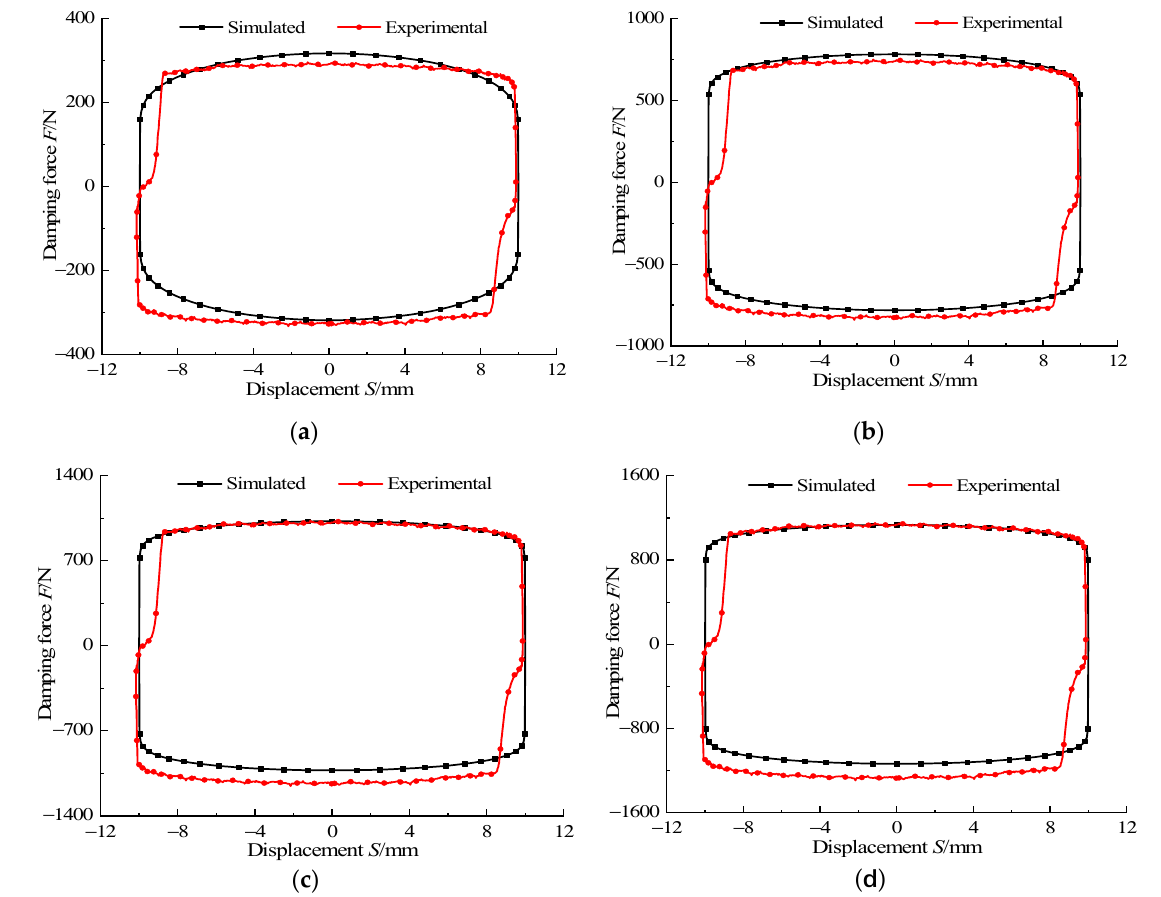
Figure 21. Comparison between simulated and experimental damping force under different currents. ( a ) Current of 0.2 A,